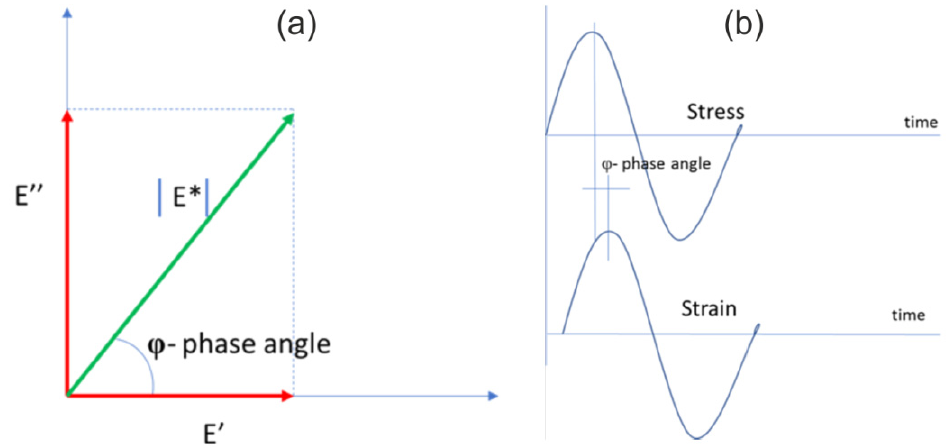
Figure 1. Complex stiffness module: ( a ) phase transfer angle; ( b ) delayed reaction of material strain in relation to loading.